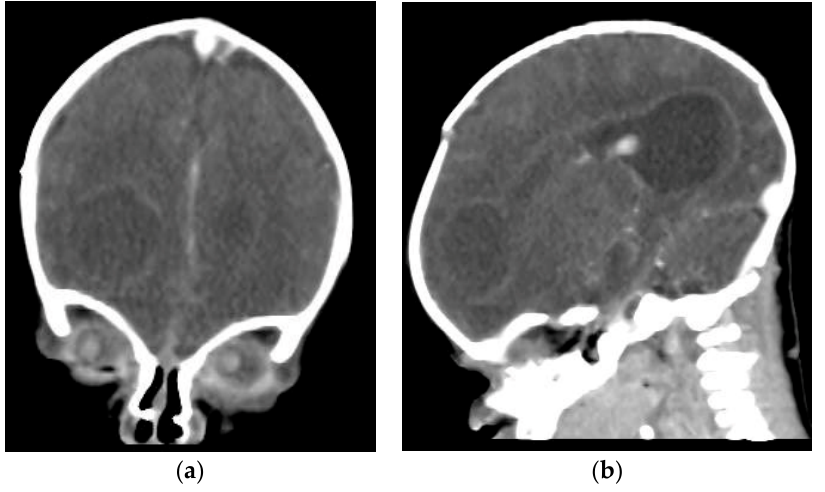
Figure 3. Cerebral CT on the 7th day of life (( a ) Coronal plan, ( b ) sagittal plan) confirmed a necrotic right frontal brain lesion, associated with peripheral linear contrast enhancement (brain abscess). In addition, the CT scan identi fi ed the widening of the right LV ( b ) and the ventricular meningeal con- trast enhancement (meningeal infection).